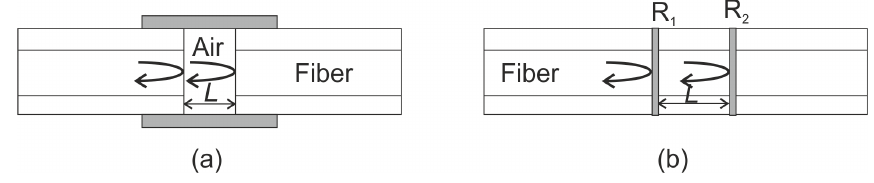
Figure 4. Principle of FPI ( a ) extrinsic ( b ) intrinsic (based on reference [47]).